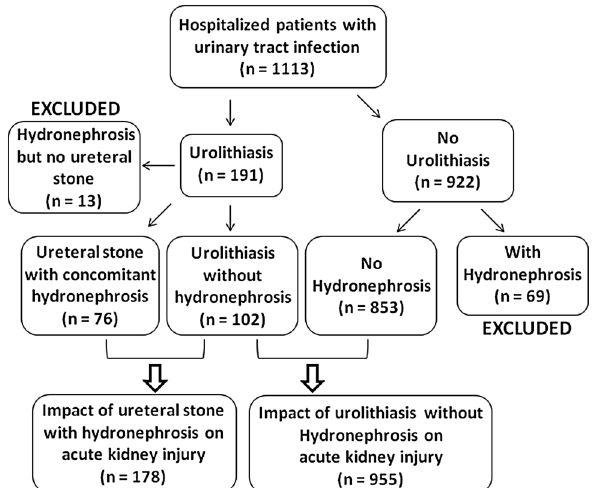
Figure 1. Flowchart of the selection of study subjects.